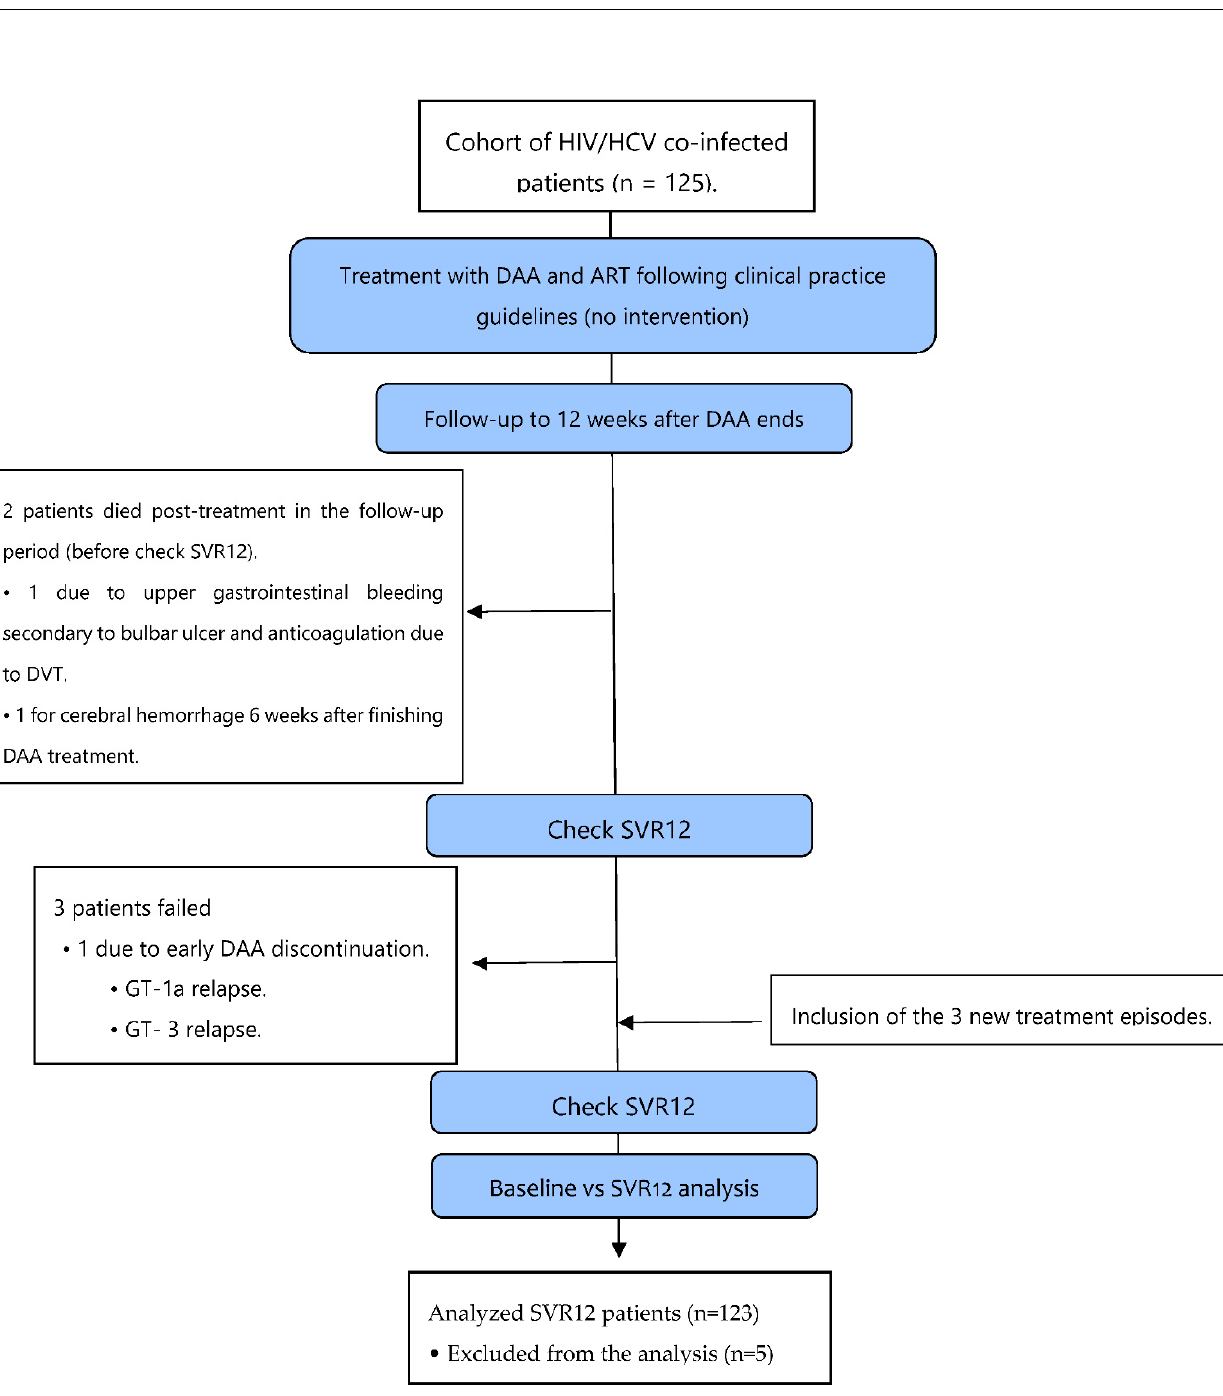
Figure 1. study flowchart. DVT, deep vein thrombosis; DAA, direct ‐ acting antiviral; ART, antiretro ‐ viral treatment; baseline, before DAA treatment; SVR12, sustained viral response 12 weeks after DAA ends; GT, HCV genotype.